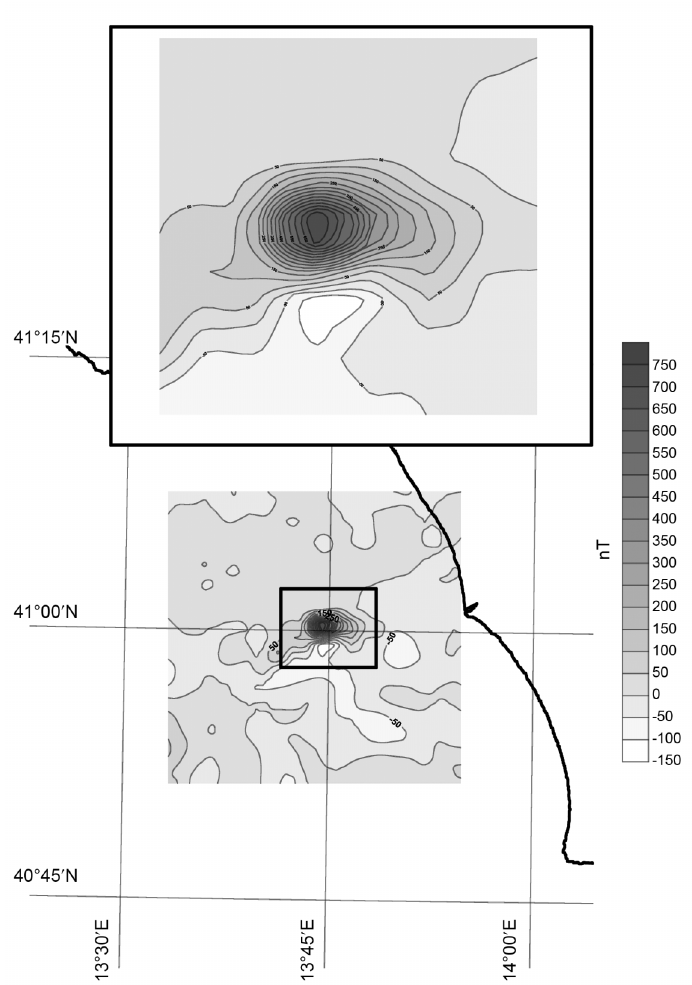
Fig. 9. The anomaly in fig. 8 has been reduced to the pole after a distortion analysis. This technique yielded D = =− 25° (335°), I =− 70° for the direction of the total magnetization vector, suggesting that most part of the source was emplaced during a reverse-polarity magnetic interval. The outlined field is zoomed in the upper